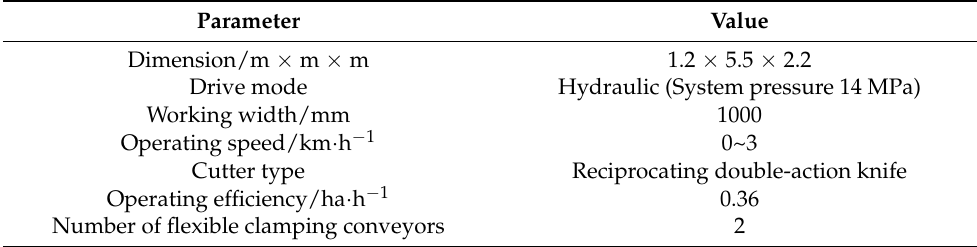
Table 1. Main technical parameters of rape shoot harvesting machine.